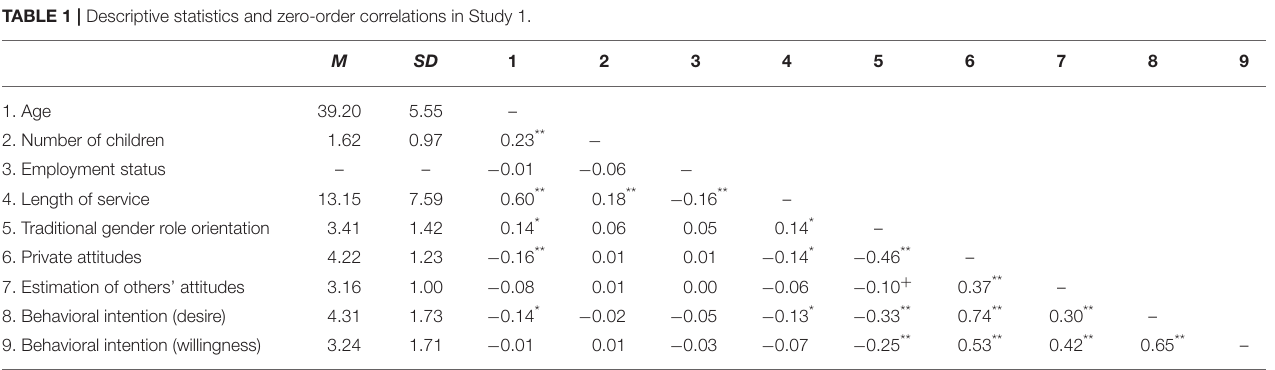
TABLE 1 | Descriptive statistics and zero-order correlations in Study